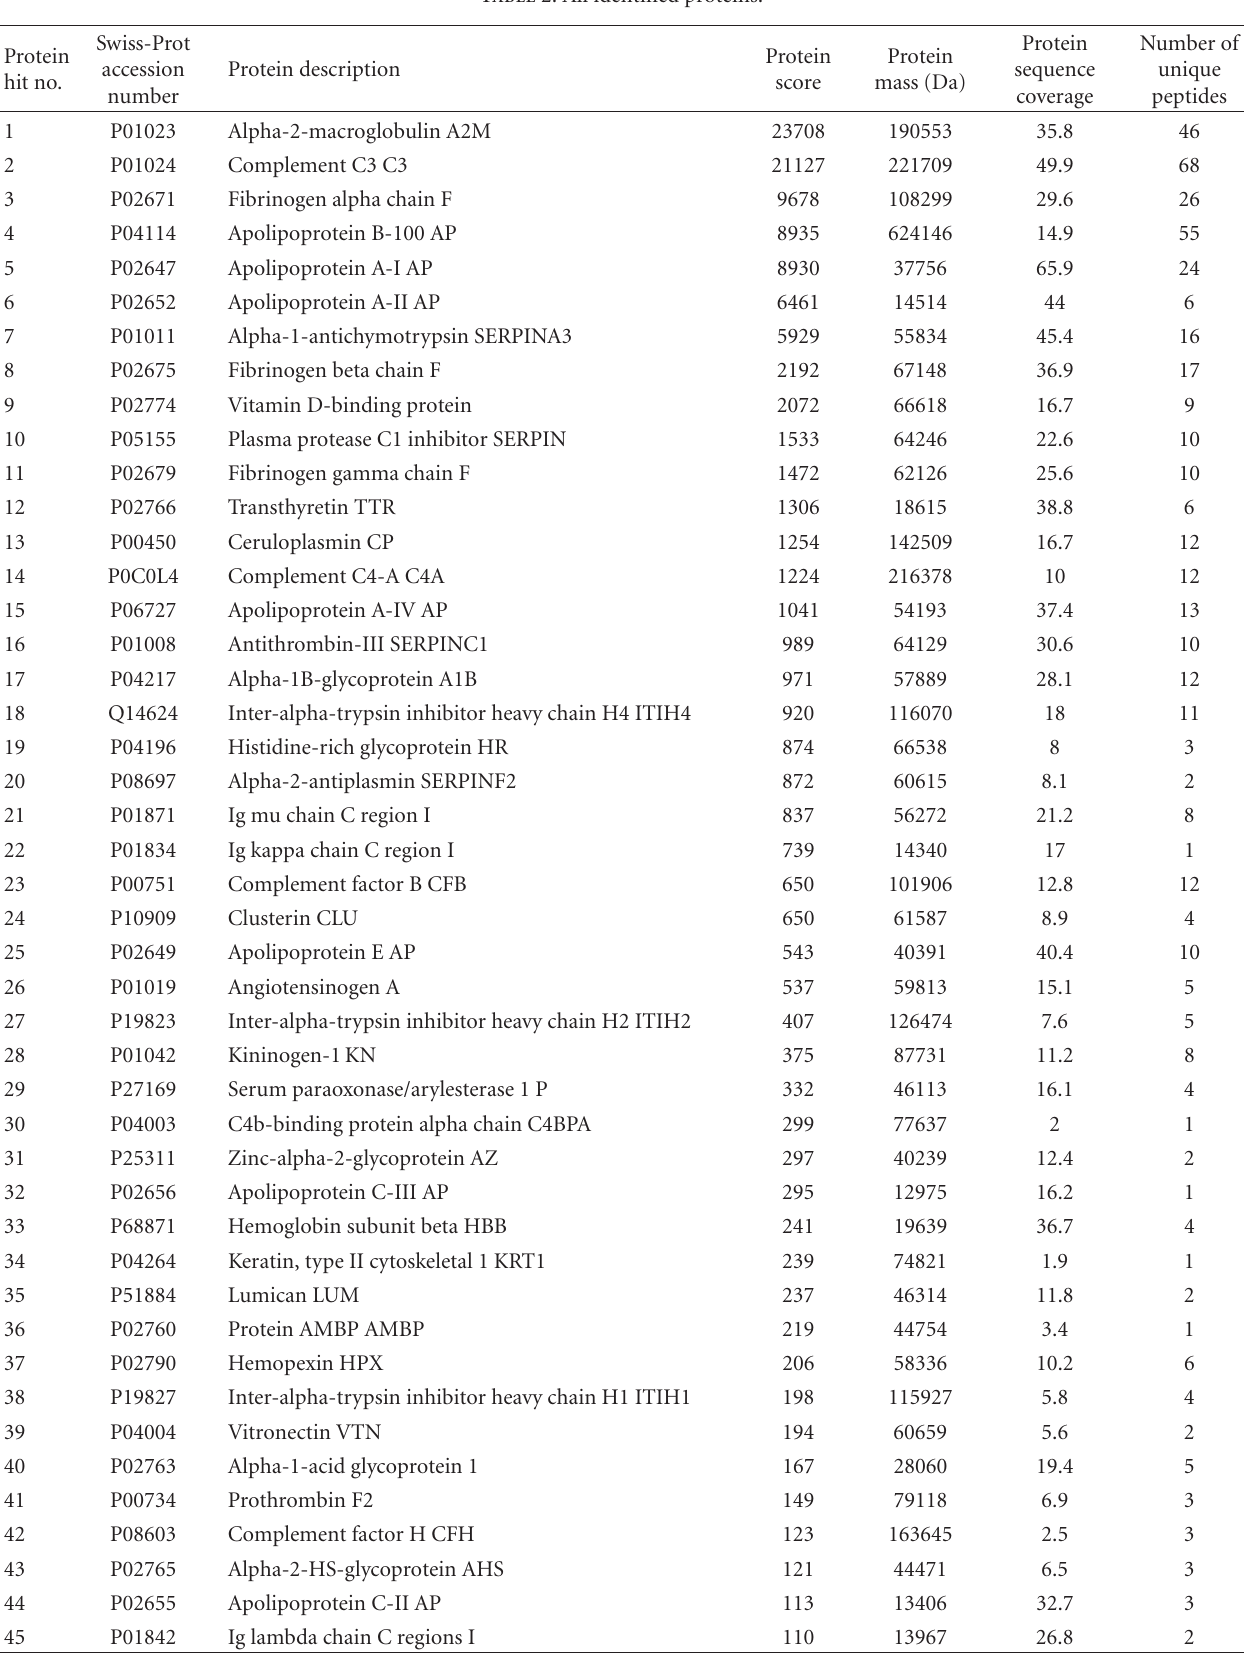
Table 2: All identified